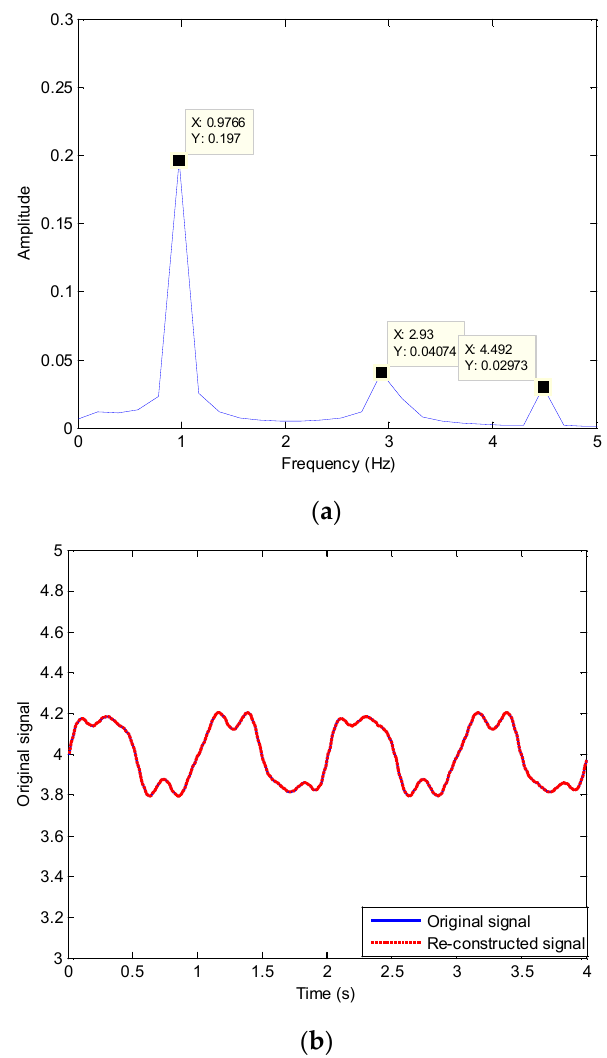
Figure 3. Re-construction of multi-frequency signals with Chebyshev polynomial. ( a ) Frequency analysis of the signal. ( b ) Re-construction based on the frequency analysis.